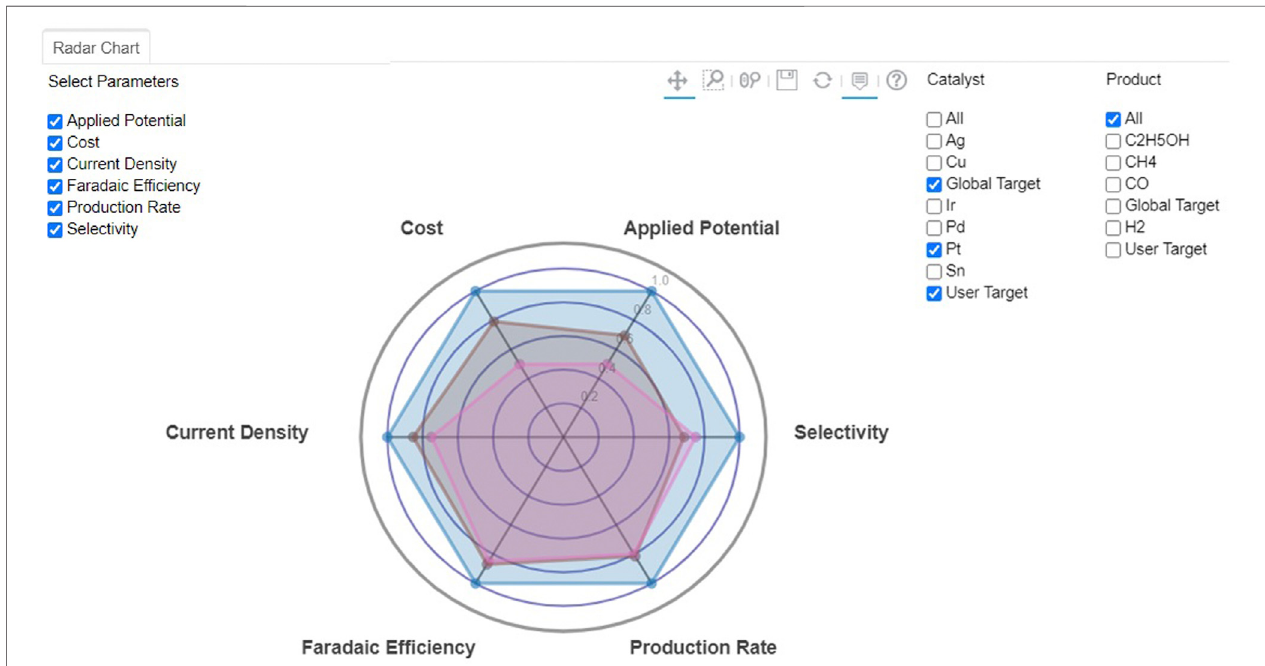
FIGURE 5 | Screenshot of radar chart for CO 2 reduction to fuels of Pt-based on different classi fi cation of electrocatalysts and selected target values by default global (blue) or user-entry (brown) targets.